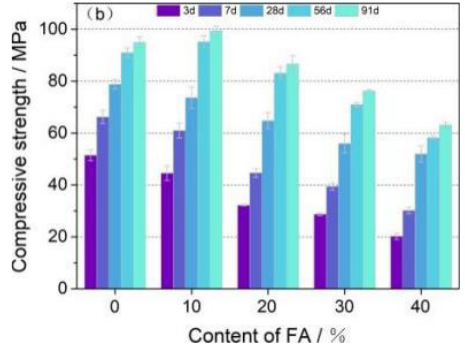
Figure 8. Compressive strength of OPC-FA samples. ( a ) Dry. ( b ) Water .